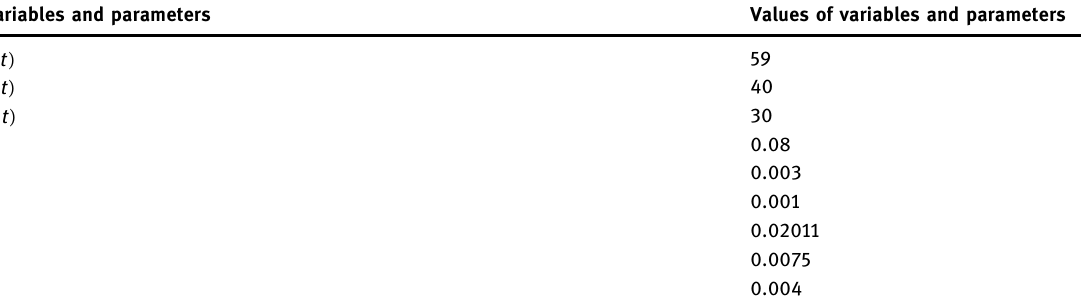
Table 2: Values of variables and parameters for numerical solution Variables and parameters